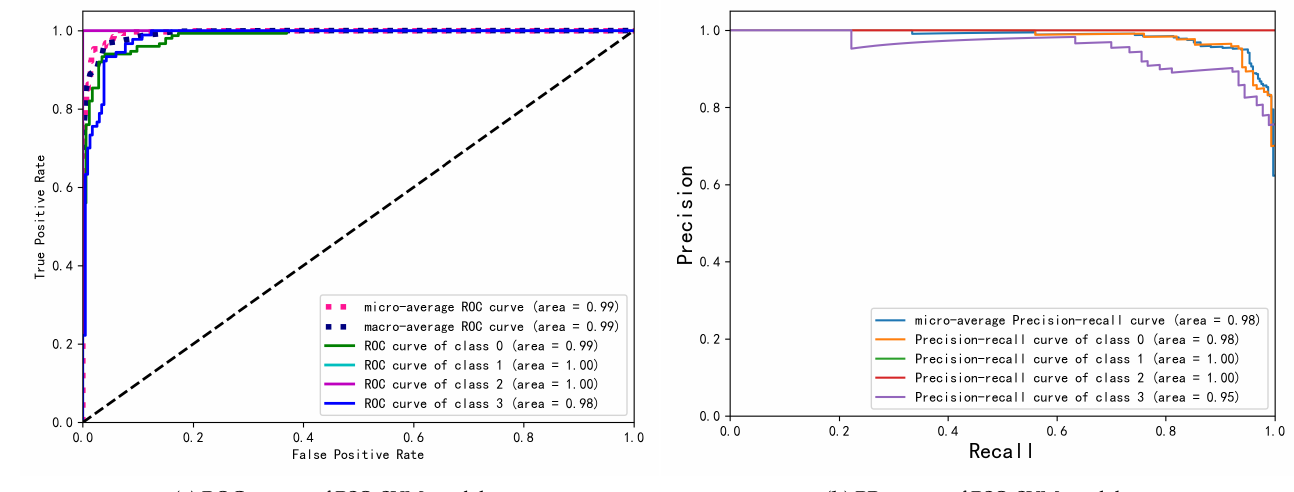
Figure 4. Comparison of different kernel function models for SVM in optical interconnect